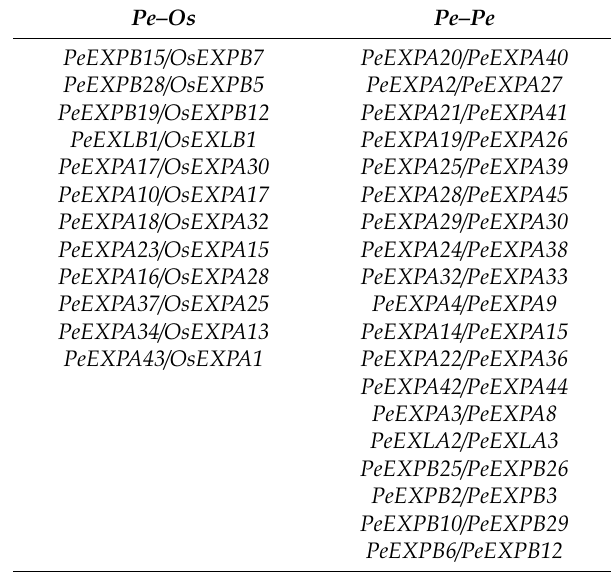
Table 3. Orthologous ( Pe–Os ) and paralogous ( Pe–Pe ) expansin gene pairs.